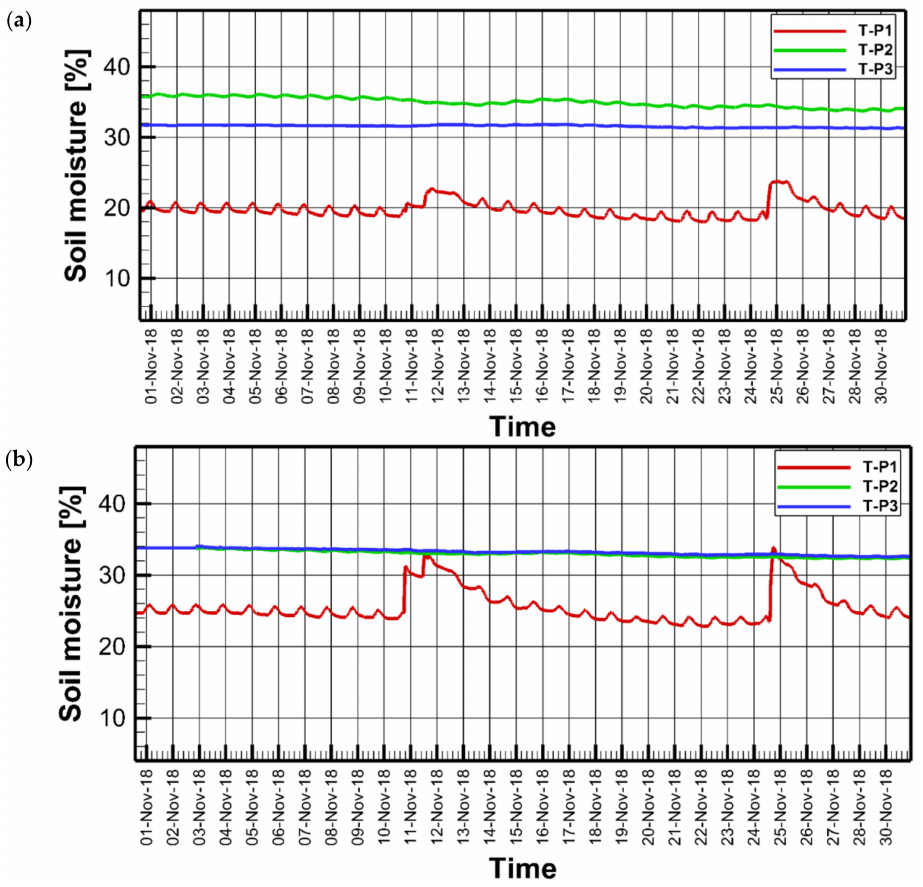
Figure 6. Soil moisture during November 2018 for lysimeter 1 ( a ) and lysimeter 2 ( b